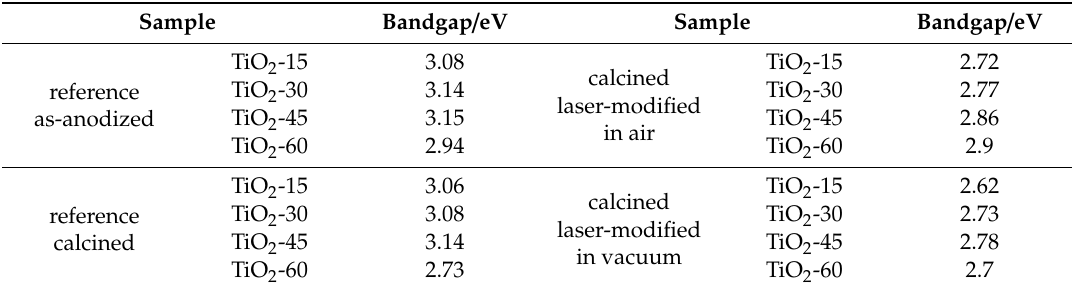
Table 2. Optical bandgap values determined from the Tauc plot curves shown in Figure